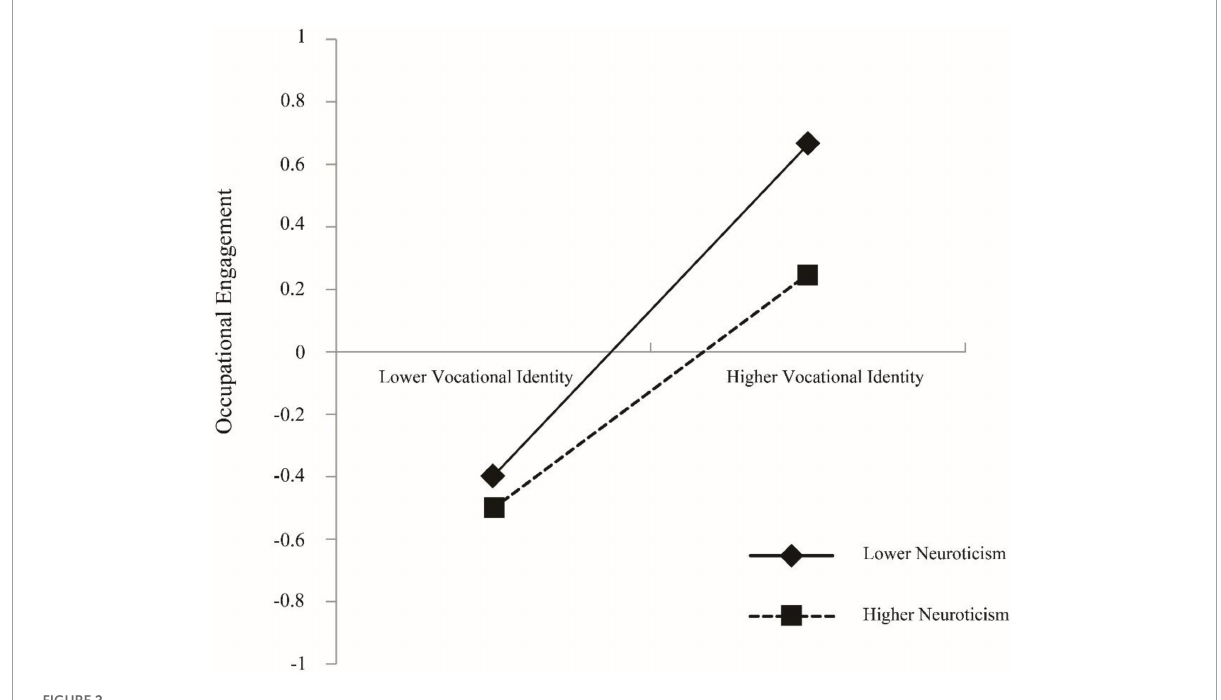
FIGURE2 The moderating effect of neuroticism between vocational identity and occupational